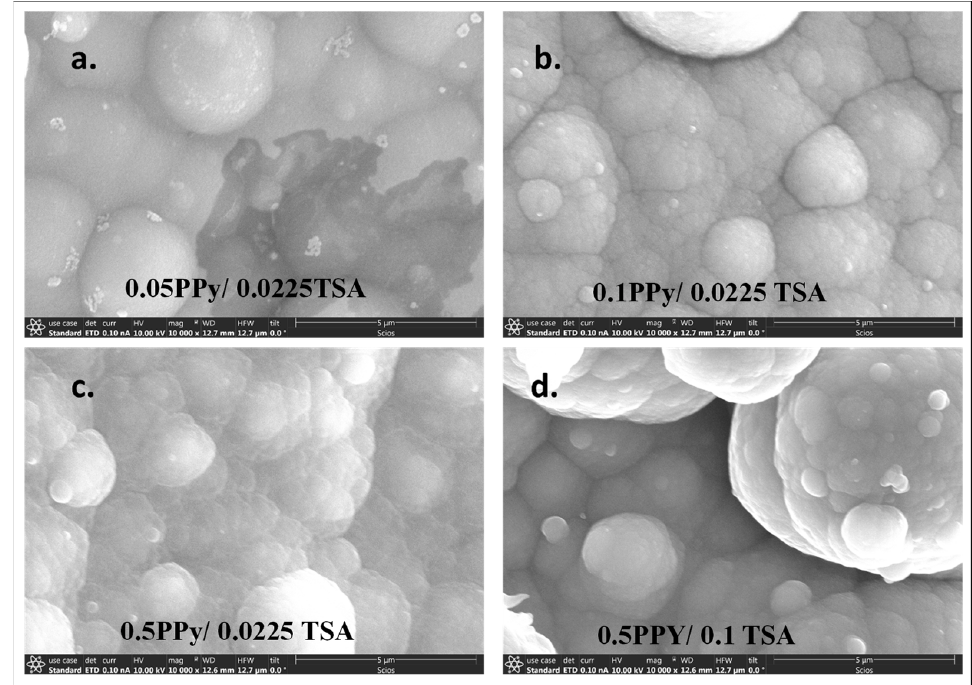
Figure 3. 10,000× magnification showing the effect of dopant and Py concentration on PPy deposi- tion and resulting surface